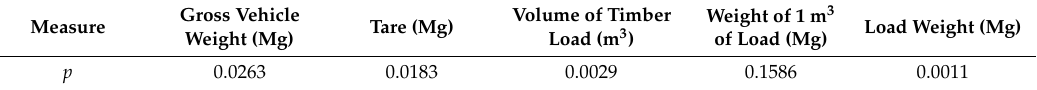
Table 2. Results of the analysis of significant differences between selected measures by type of truck unit.